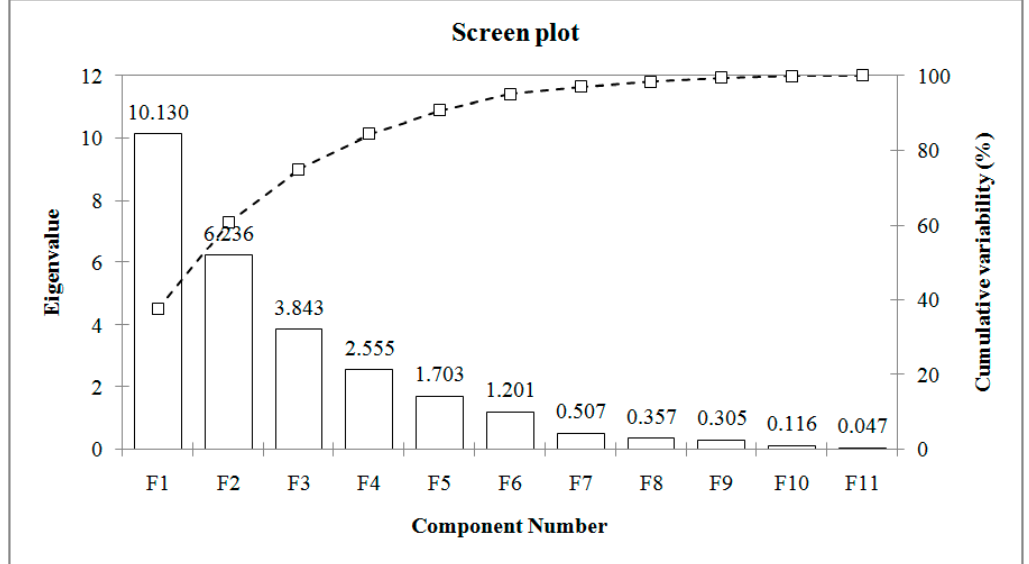
Figure 1. PCA screen plots of fatty acids on all samples and variables. Principal Component Analysis (PCA) also identifies clear differences and affinities in the composition of fatty acids between samples and groups of animals, respectively (Figure